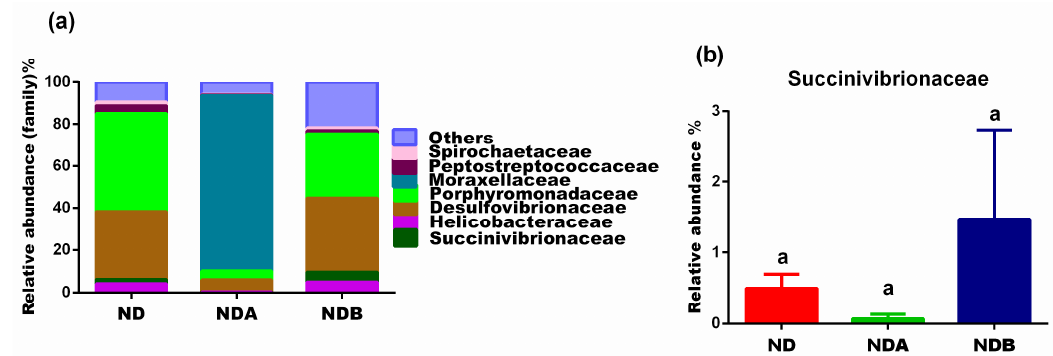
Figure 6. Effects of urolithins on gut microbial composition at the family level. Relative abundance at the family level ( a ), relative levels of Succinivibrionaceae ( b ). a Data are expressed as mean ± SE. Mean values bearing different letters are significantly different ( p < 0.05).